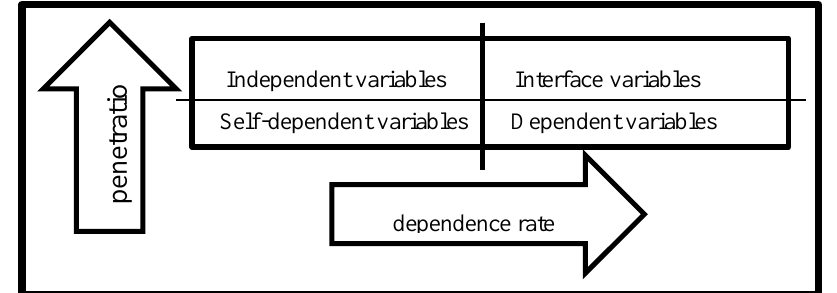
Figure 1: dependence rate and guidance power in the method